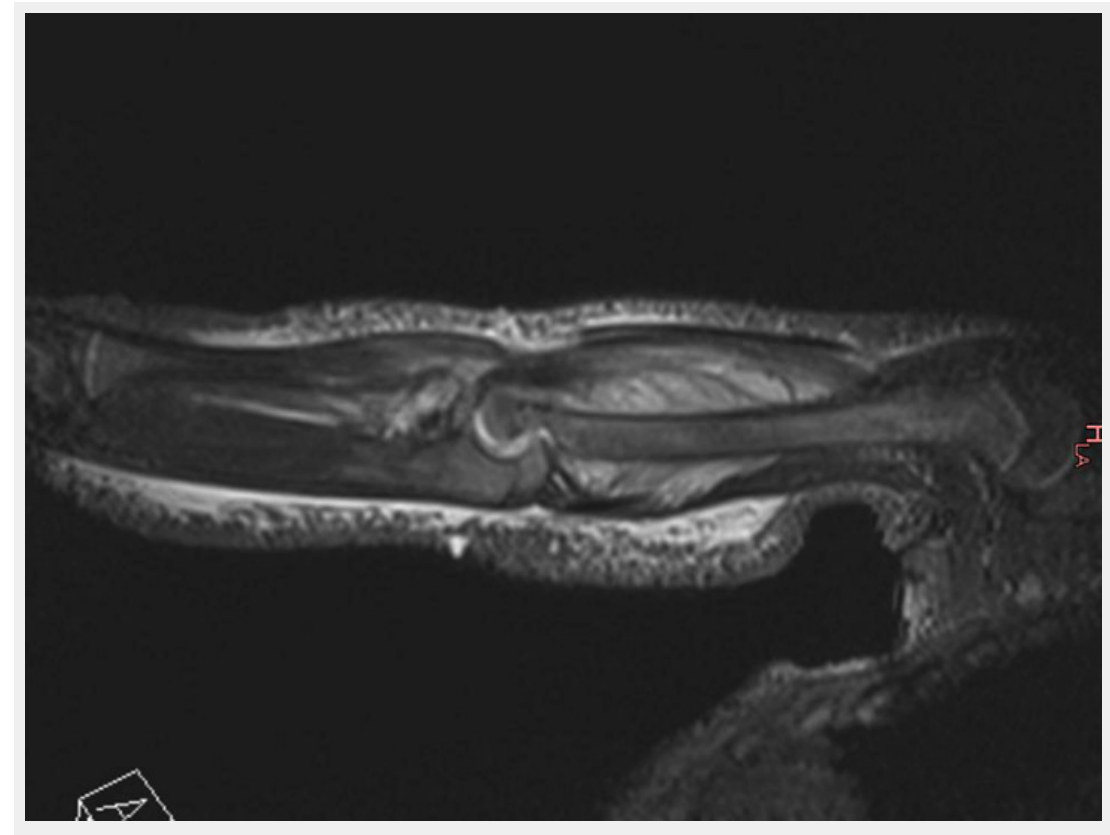
Figure 2 Acute pandiaphysitis of the right humerus with an important sub-periosteal abscess in a 16-month-old girl. The osteomyelitis was due to Haemophilus influenzae type B despite the child being completely